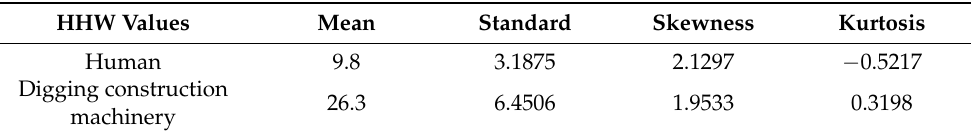
Table 3. Statistical parameters for quantitatively describing differences between HHW values of human and digging construction